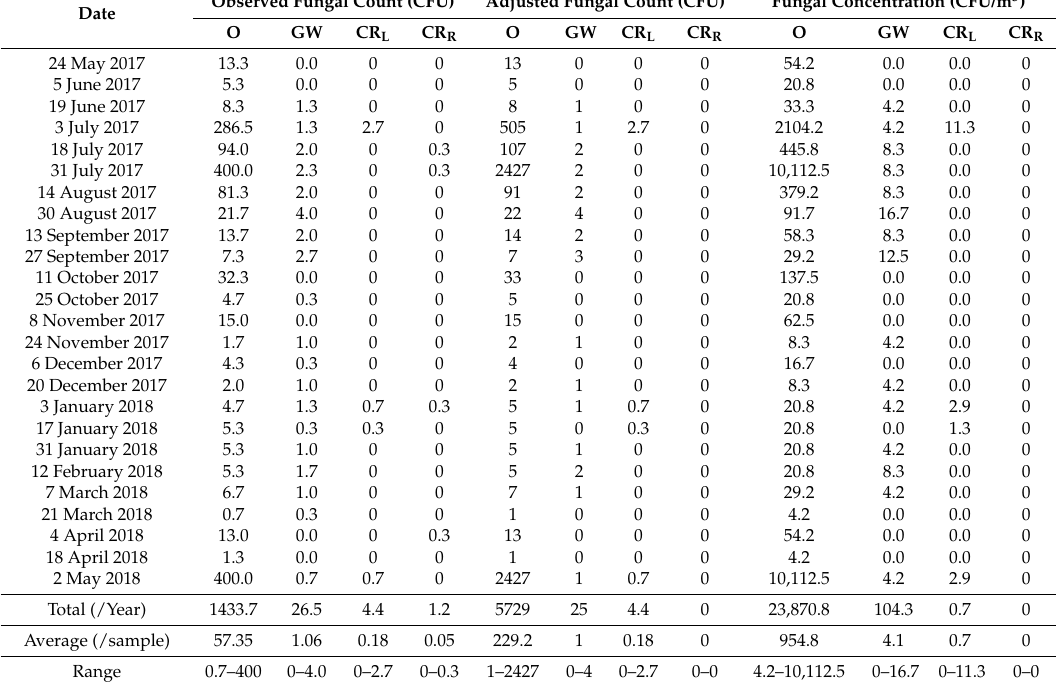
Table 2. Fungal colony count and concentrations at each location according to air sampling time throughout the year.